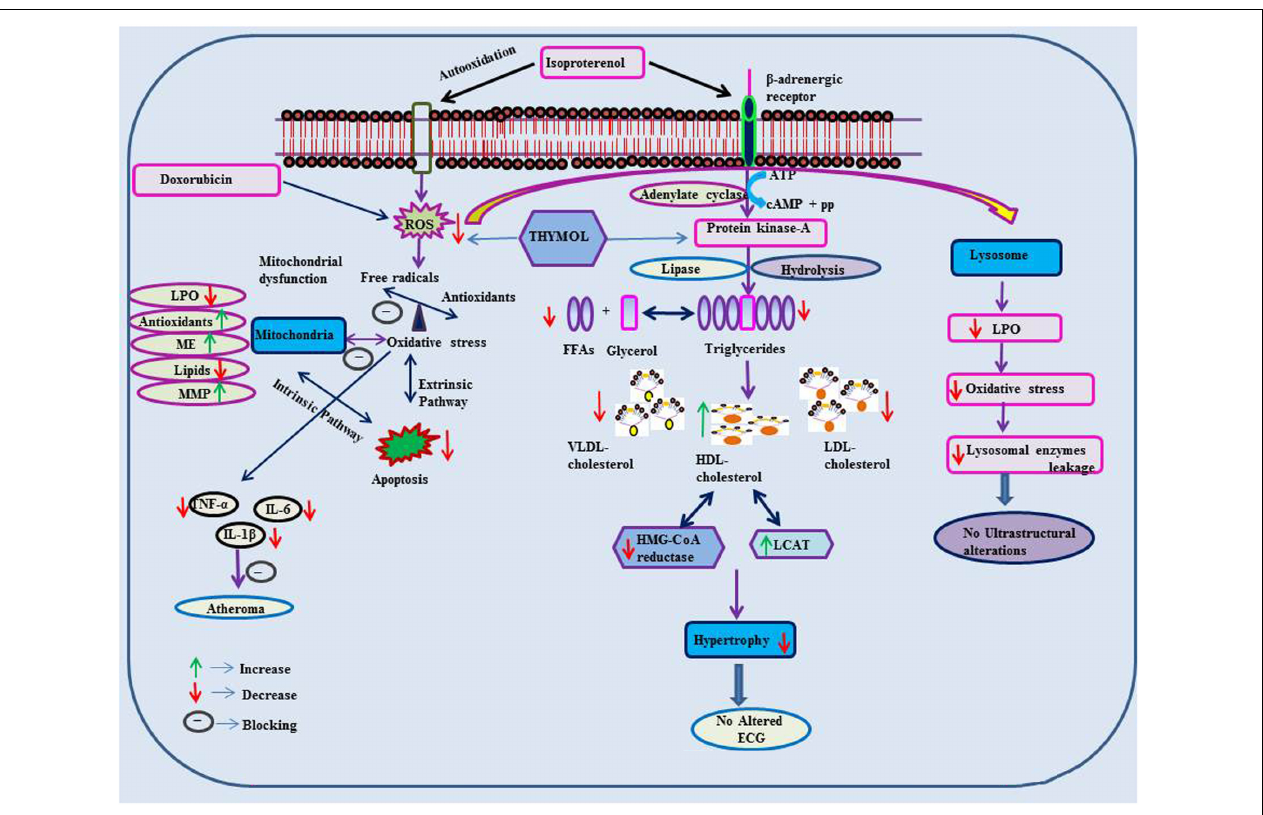
FIGURE 2 | Effect of thymol on ISO and doxorubicin induced